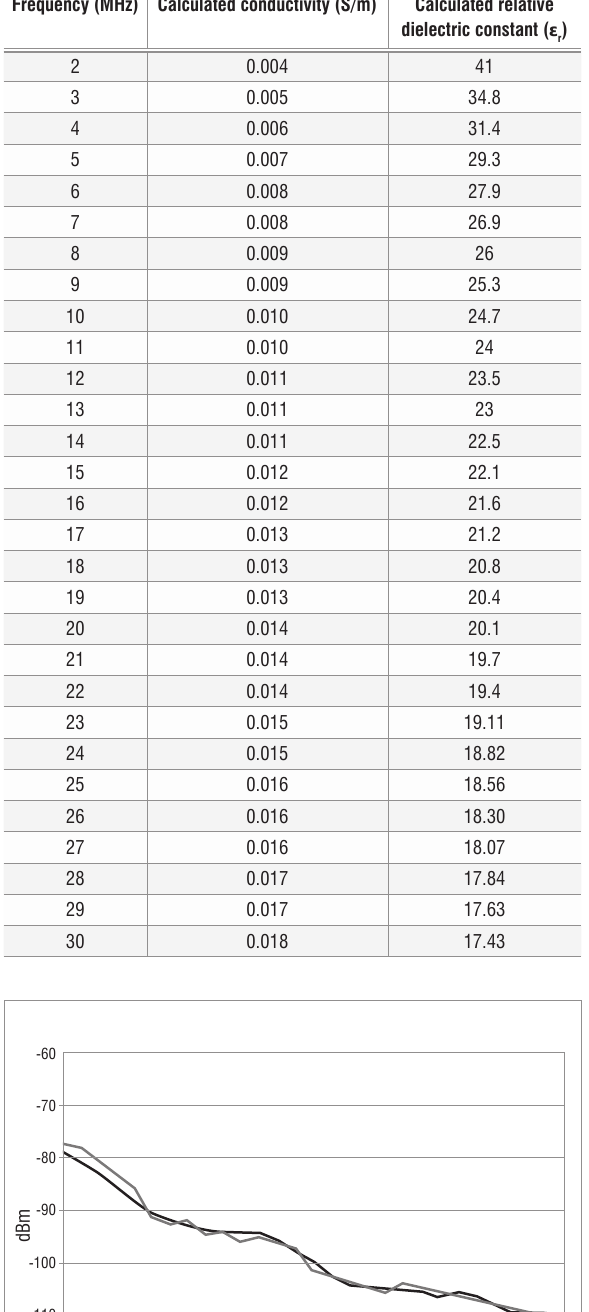
Table 1: Calculated conductivity and relative dielectric constant over the 2–30-MHz range for a 17.3% ground moisture content Frequency (MHz) Calculated conductivity (S/m) Calculated relative